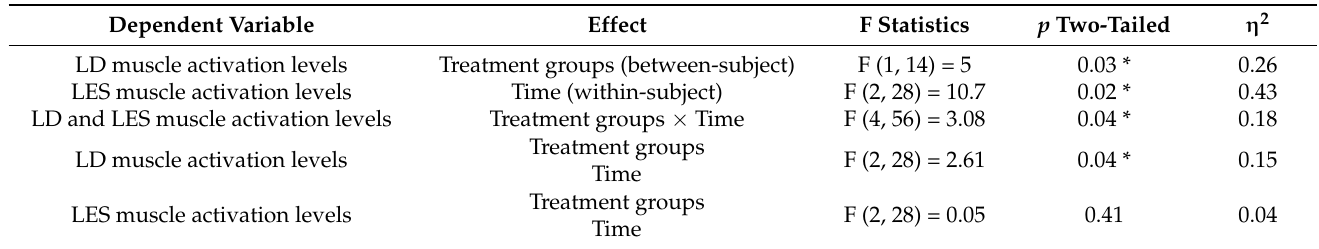
Table 6. Mixed-design repeated measures ANOVA test results with the lateral bending posture (30 ◦ right lateral flexion).